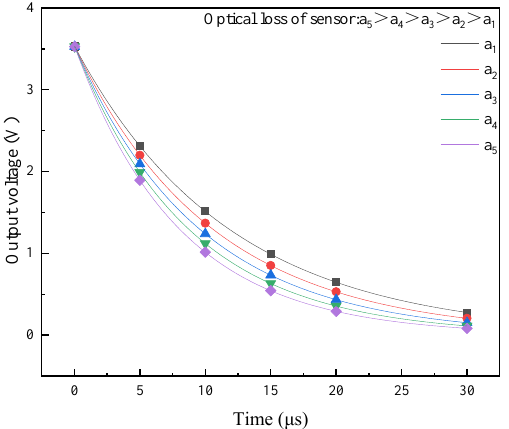
with the largest voltage signal change, due to the change of optical loss, which could be used as the pulse signal for judging the detection limit. Figure 9. Ring-down curves under the different sensor optical losses. Figure 9. Ring-down curves under the different sensor optical losses.